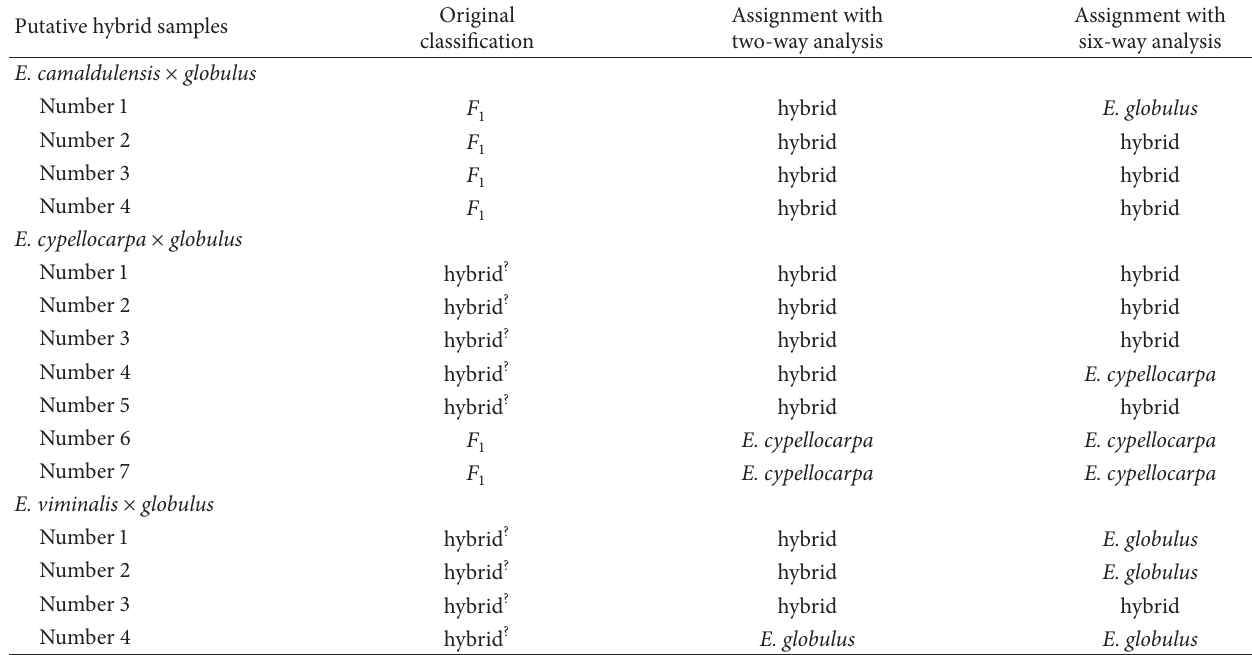
Table 4: The assignment of 15 putative eucalypt hybrid samples based on their mean q values, with q > 0.2 to indicate hybrid status under the two-way and six-way STRUCTURE analyses. Putative hybrid